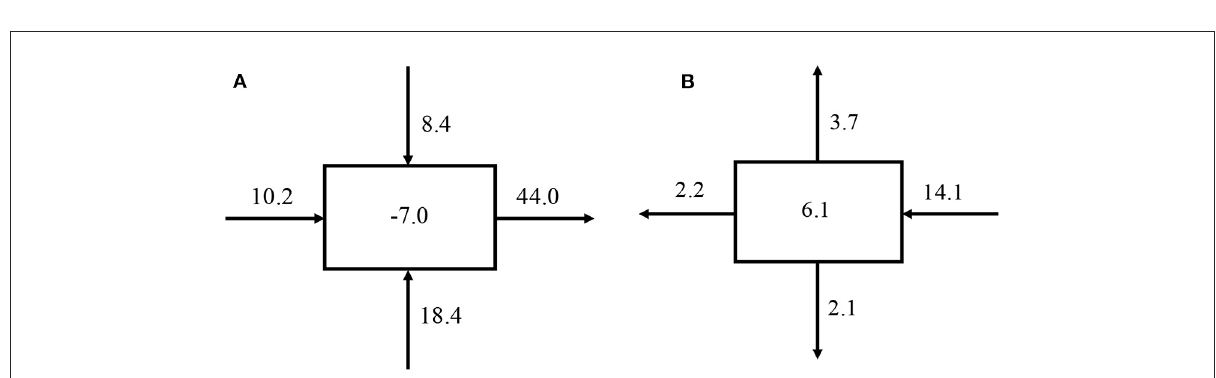
FIGURE5 Boundary moisture budget anomalies over Northwest China during (A) 1961–1990 and (B) 1991–2018 (unit: 10 6 kg/s) (Wu et al.,